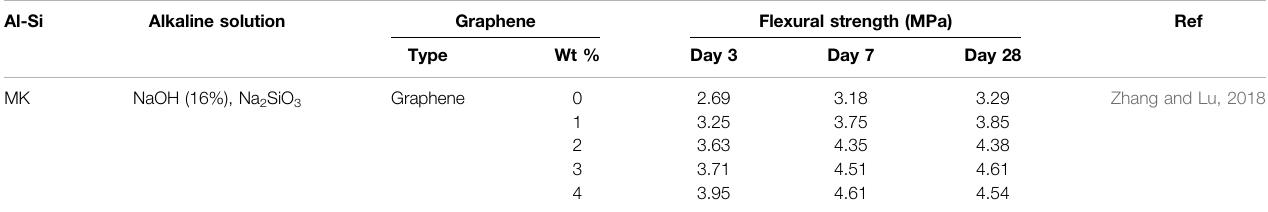
Al-Si Alkaline solution